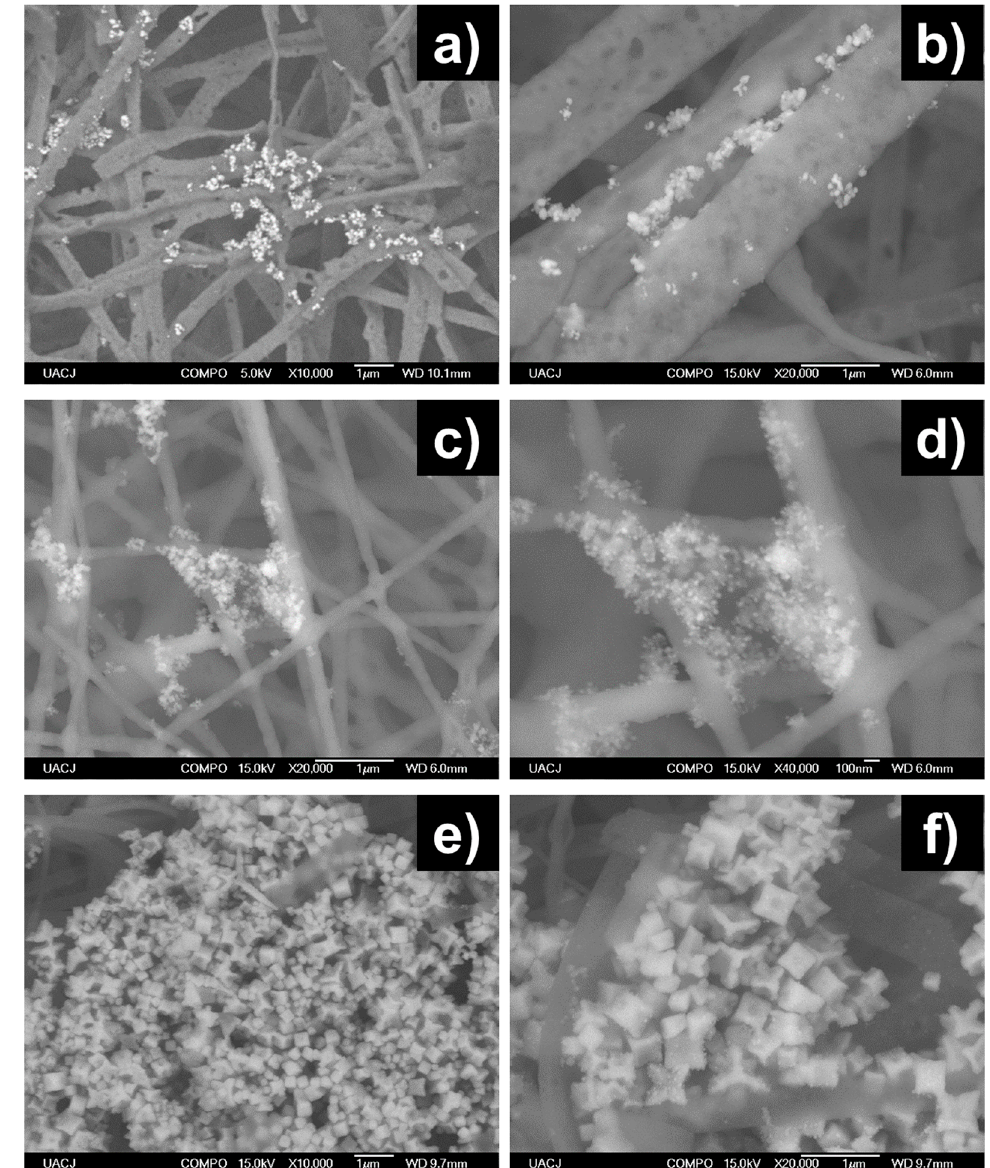
Figure 6. Micrographs of the SiO 2 –HA–Ag composite from supports F4 to F6: ( a ) F4 at 20,000× and ( b ) 40,000×; ( c ) F5 at 20,000× and ( d ) 40,000×, and ( e ) F6 at 10,000× and ( f ) 20,000×.